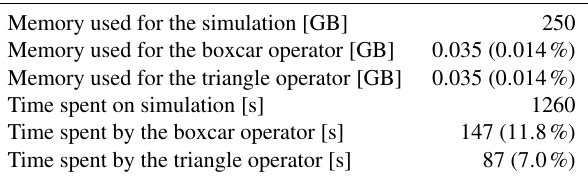
Table 2. Comparison of the two filtering kernels’ performance.